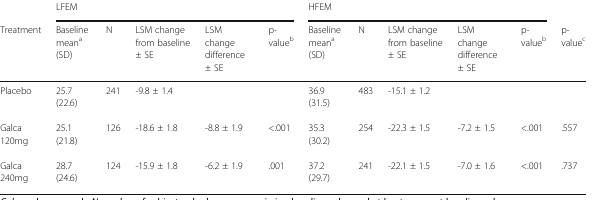
Table 3 (abstract O17). Migraine disability assessment total score, month 6 LFEM HFEM Treatment Baseline mean